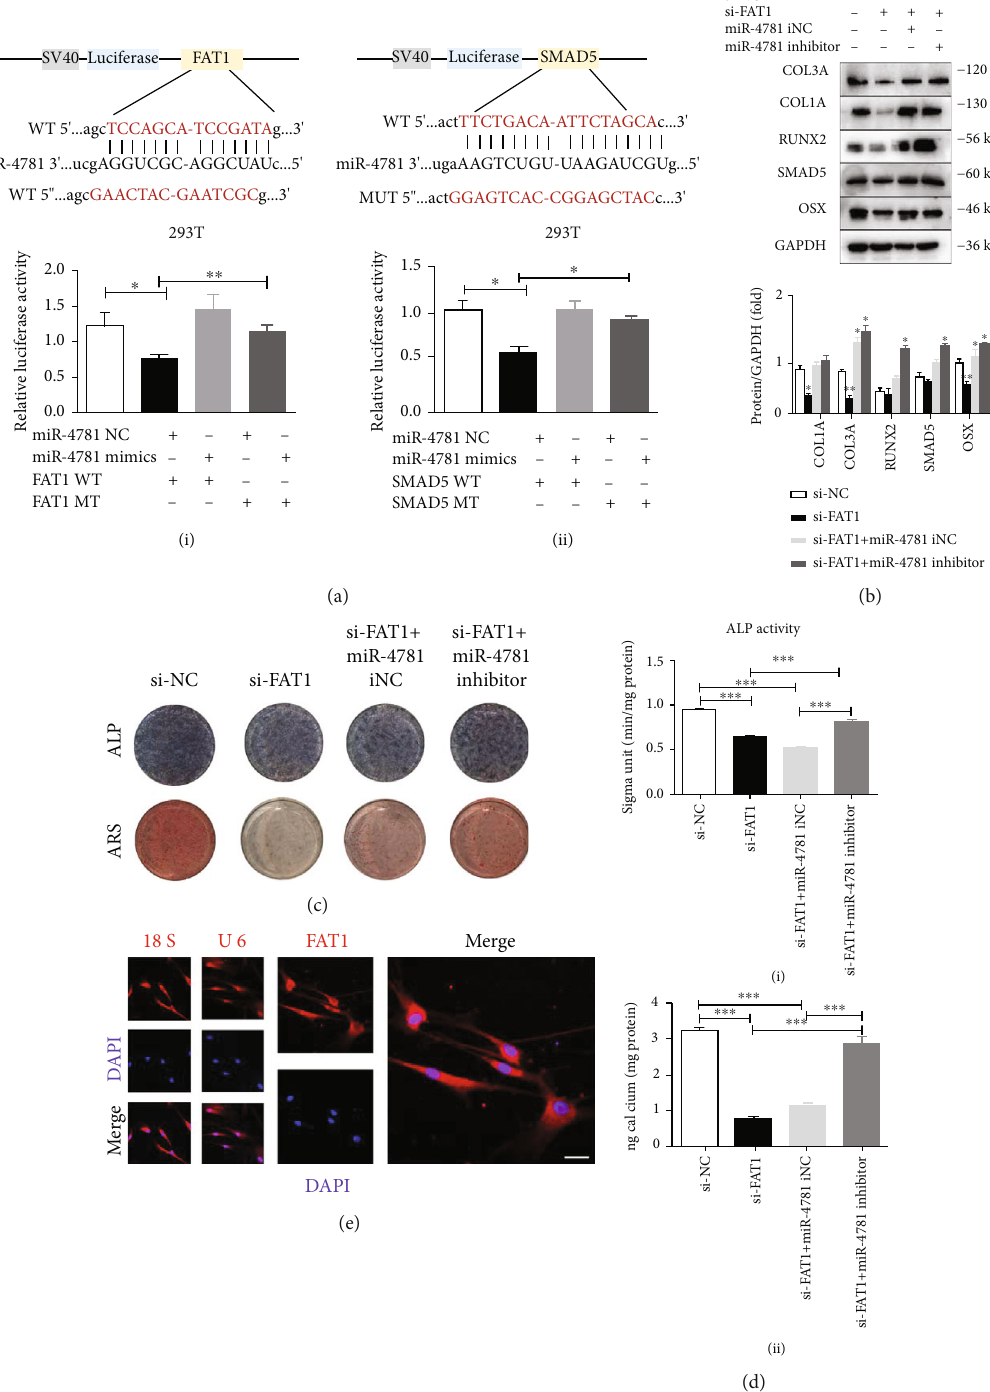
Figure 7: circFAT1 acting as a miRNA sponge for miR-4781-3p by targeting SMAD5. (a) I: Dual-luciferase reporter gene assay was used to verify the binding sites between circFAT1 and miR-4781-3p. II: Dual-luciferase reporter gene assay was used to verify the binding sites between SMAD5 and miR-4781-3p. (b) Rescue experiment results showed that miR-4781 inhibitor could reverse the inhibition of circFAT1 siRNA on the osteogenic ability of PDLSCs. The expression level of SMAD5 was also reversed by miR-4781 inhibitor. (c) After seven days, less expression of ALP was found in the si-FAT1 group and si-FAT1 + miR-4781 iNC group, while the expression of ALP increased in the si-FAT1 +inhibitor group. The mineralization nodules in the si-FAT1 group and si-FAT1 +miR-4781 iNC group decreased. (d) I: ALP activity showed the same trend. II: Mineralized nodules were signi fi cantly increased in the si-FAT1 + inhibitor group, and calcium content was signi fi cantly increased ( P < 0 : 001 ). (e) FISH experiments proved that circFAT1 were mostly located in the cytoplasm, 18S and U6 were the internal control. (Scale bar: 25 μ m). ∗ P < 0 : 05 , ∗∗ P < 0 : 01 , and ∗∗∗ P < 0 : 001